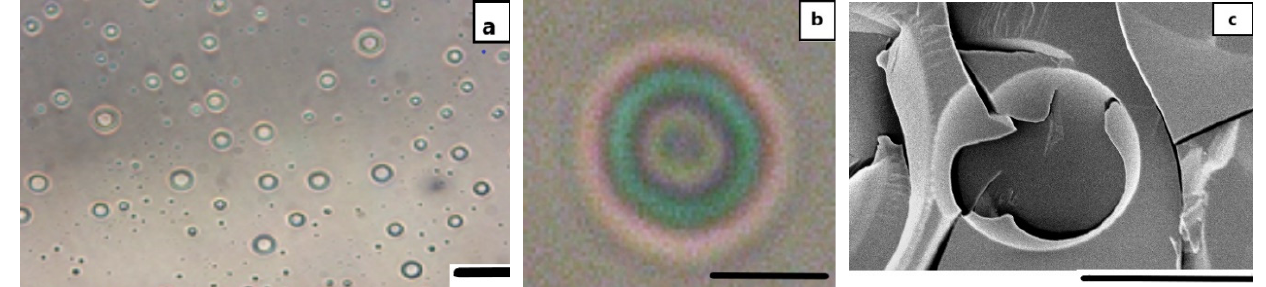
Figure 2. Light micrographs of a freshly prepared Janus emulsion with chitosan-stabilized AuNPs (scale bar: 20 µm) ( a ), one individual Janus droplet with a red-colored AuNP layer (scale bar: 5 µm) ( b ) and a cryo-SEM micrograph of a broken Janus droplet (scale bar: 5 µm) ( c ).